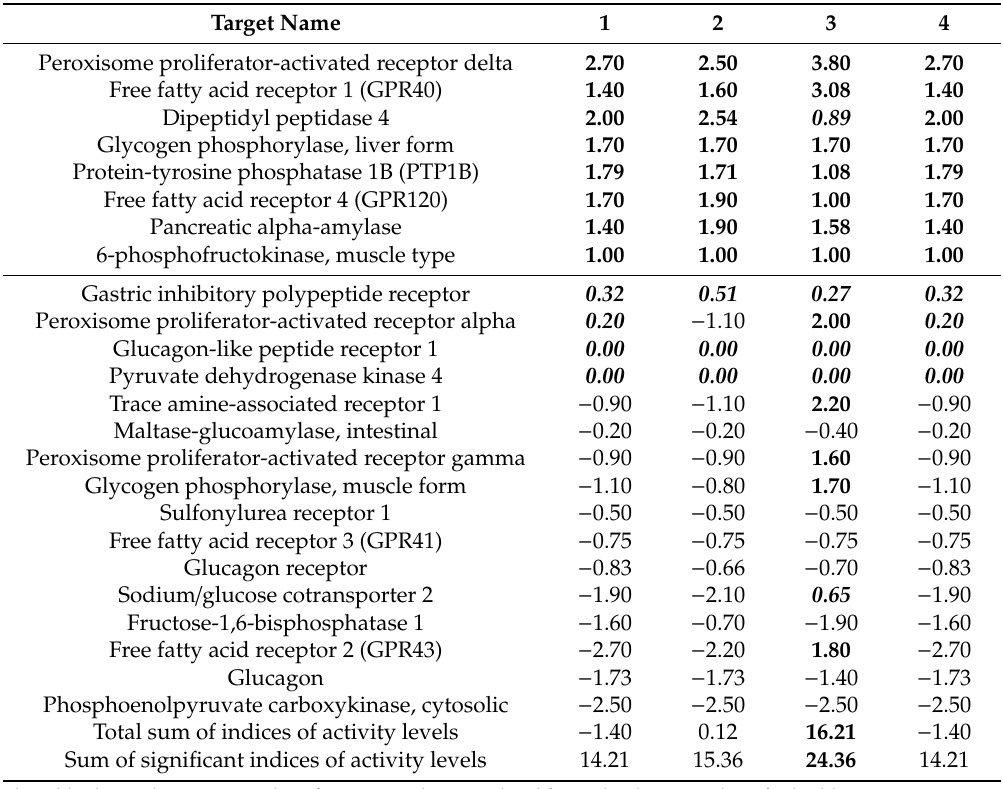
Table 3. Profiles of targeted hypoglycemic activities of bornyl derivatives 1 – 4